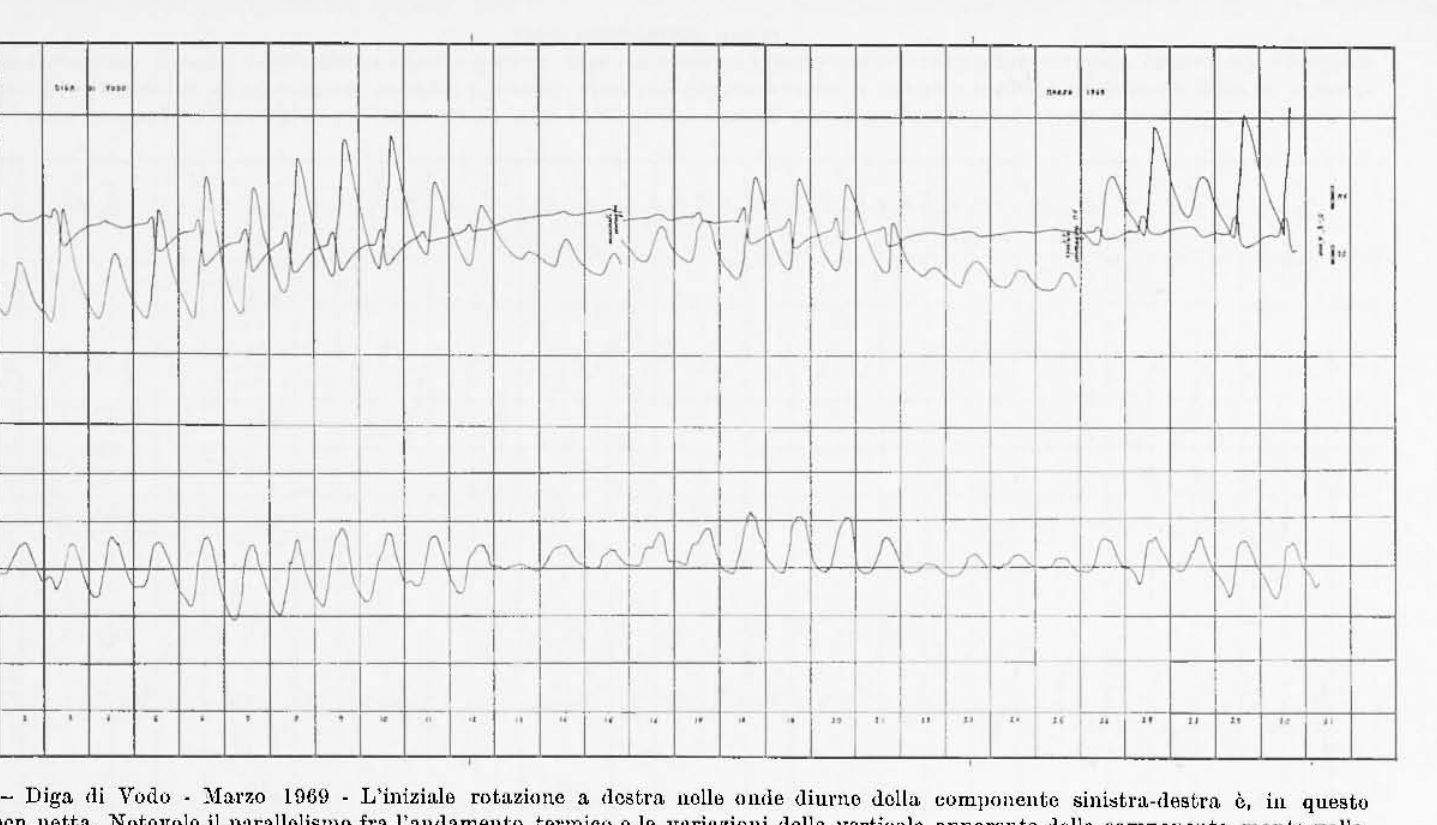
Fig. 5 - Diga di Vodo· :J.Ia.I'W Hl69 - L'iniziale rotazione a destra nolle onde diurno dolla eUill]lollellte sinistra-destra è, in questo mese, ben netta. Notovo!o il parallelismo fra l'andamento termico e lo variazioni della vortiealo apparente della eOillponcllto monte-vallo. Lo variaziuni :J. lungo perio,lo rlella componente sillistra-,lesira sono illeerte per quanto concerne il